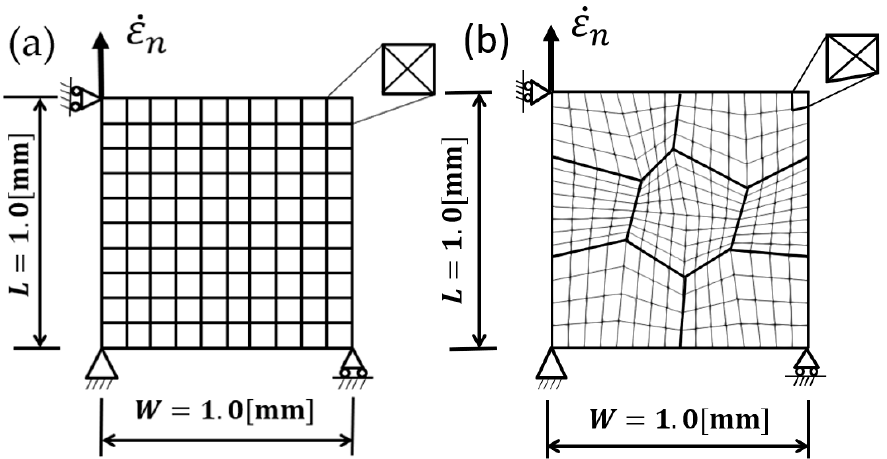
Figure 1. Finite element models of ( a ) monocrystal and ( b ) 4-grain polycrystal TRIP steel [24,27,42].